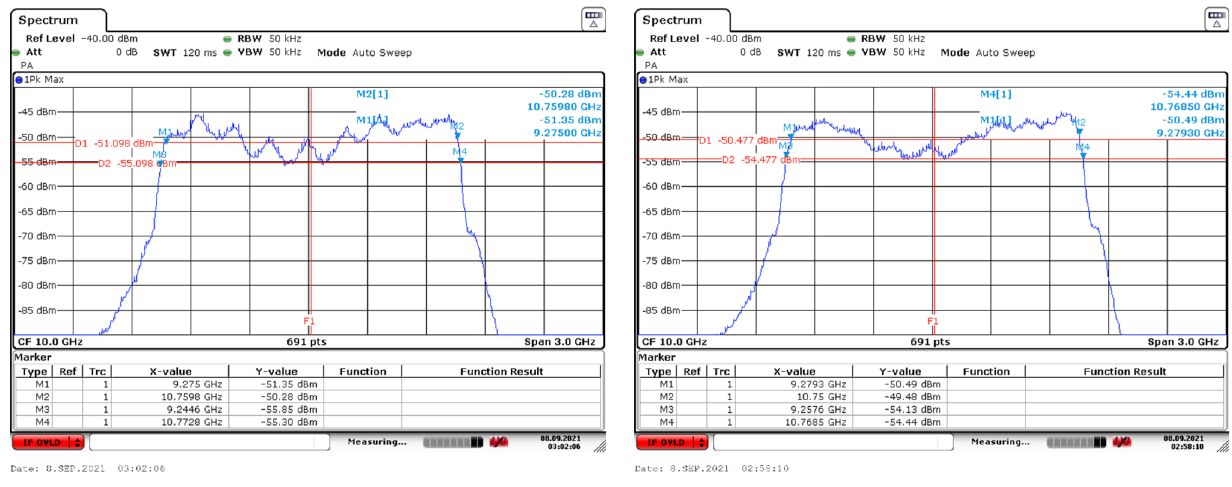
Figure 14. Noise spectrum: Thermal noise ( left ) and PRS noise ( right ). A low noise amp/down converter (LNDC) consists of receiving and reference channels for correlation processing of noise signals. The receiving channel blocks the transmission leakage power from the transmission antenna. It has a wide dynamic range for simultane- ously processing a highly reflective signal from a distance of several meters and a low signal reflected from the maximum detection distance. The reference channel stably amplifies